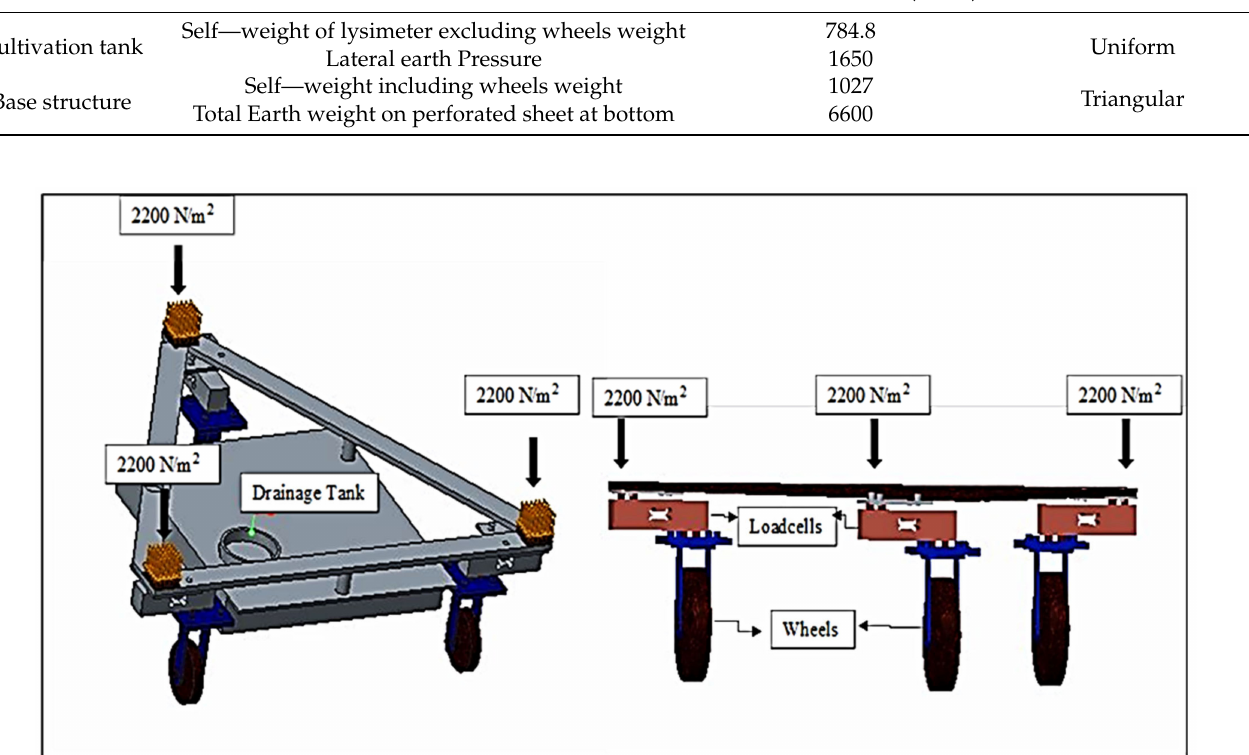
Figure 9. Triangular load distribution acts on loadcells at the bottom structure of the